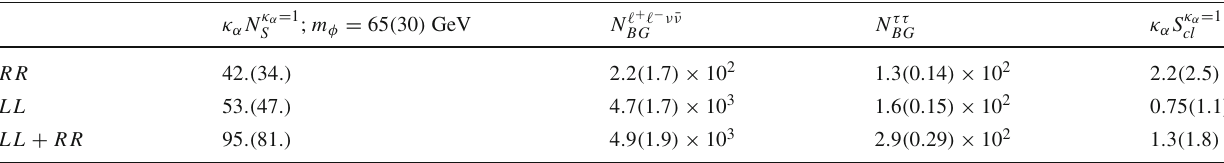
Table 3 The number of events for signal ( N S ), BG ( N BG ) and significance ( S cl ) for RR and LL polarizations with integrated luminosity of 900 fb − 1 each and for sum of events from two polarizaitons, where we show cases for m φ = 65 ( 30 ) GeV with all kinematical cuts imposed